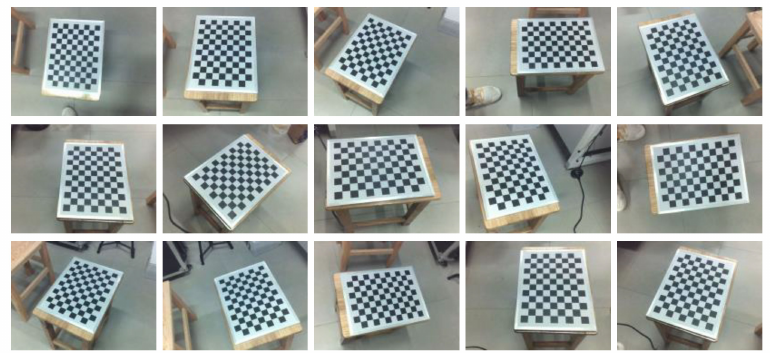
Figure 10. The images of the calibration board acquired by the left camera.